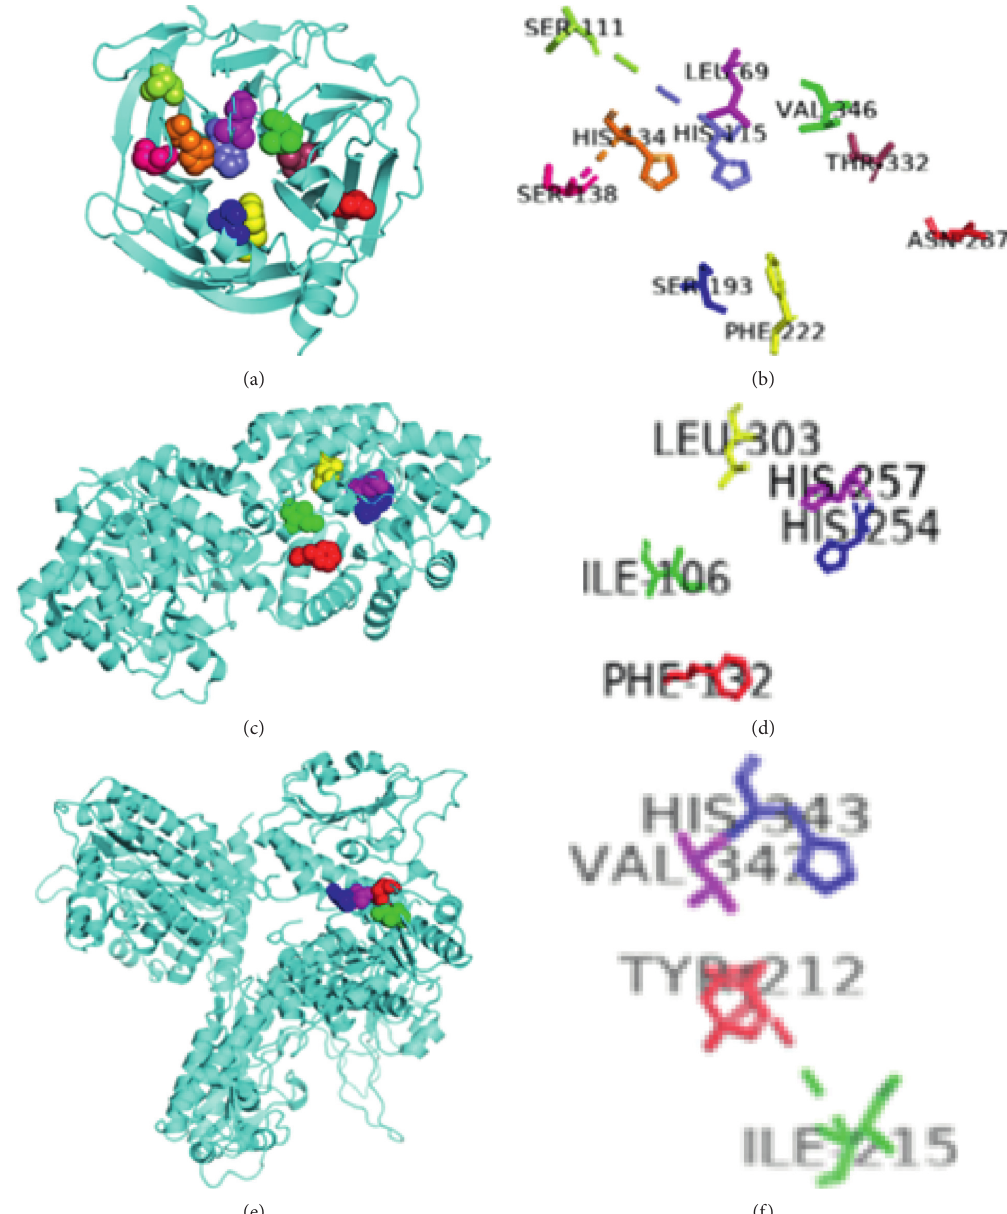
Figure 5: Illustration represents residues important for stereoselectivity of the enzymes: (a) PON1 cartoon structure with different coloured sphere-shaped residues; (b) PON1 residues as sticks; (c) PTE cartoon structure with different coloured sphere-shaped residues; (d) PTE residues as sticks; (e) OPAA cartoon structure with different coloured sphere-shaped residues; (f) OPAA residues as sticks. (For creating the above structures, basic structures were taken from PDB ID: 1V04, 3CAK, and 3L7G, and PyMOL software was